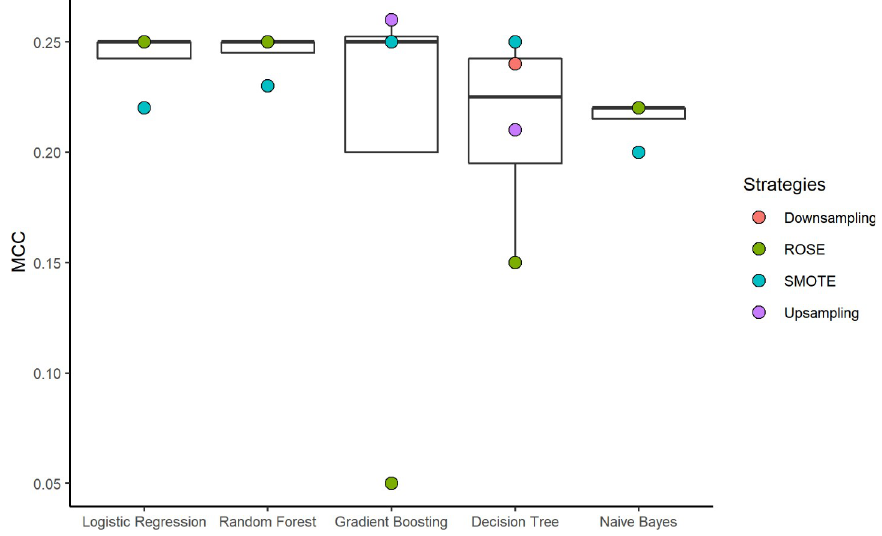
Fig 2. Boxplots representing the Matthews Correlation Coefficients (MCC) of each model and balancing technique combination (points) for all methods. Boxplots represent the distribution of MCC values for each model and balancing technique combination. The higher the MCC value, the better the